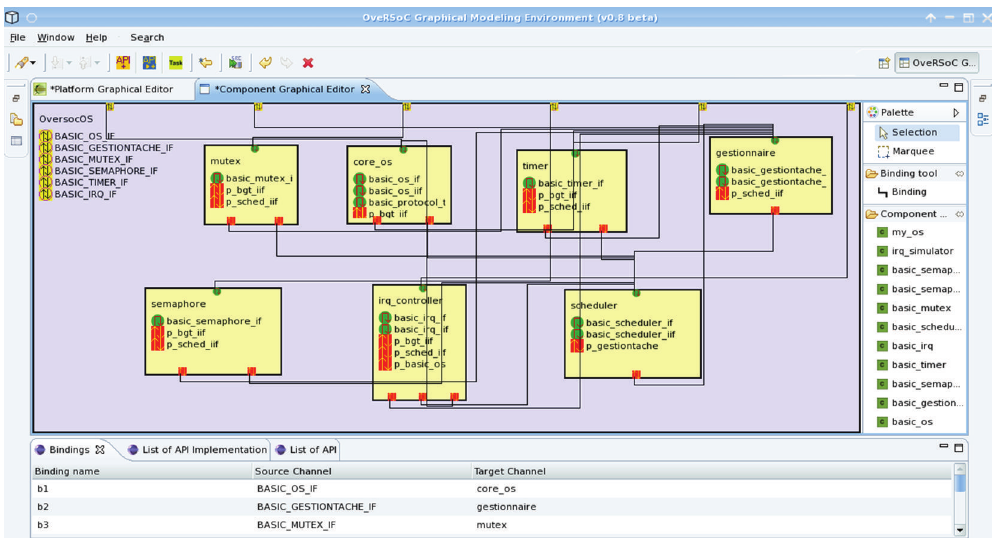
Figure 5: The DOGME tool represents a distributed RTOS through hierarchical views: the Component Graphical Editor, where the services are organized inside each PE, and the Platform Graphical Editor, where the groups of services are composed according to the number and type of PEs into the RSoC platform. Here the Component Graphical Editor is shown. It uses toolbox components to specify and customize the services of a dedicated group. Each service is modeled as a software (C++) component having ports and interfaces. Each service component provides several service functions.